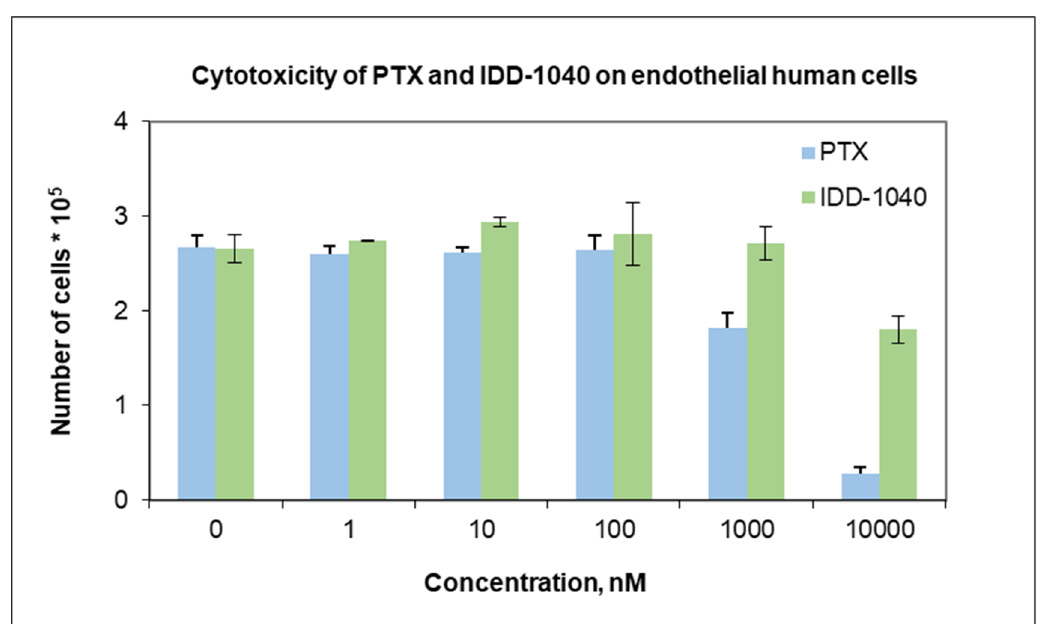
Figure 9. Cytotoxicity of PTX (blue) versus IDD-1040 (green).